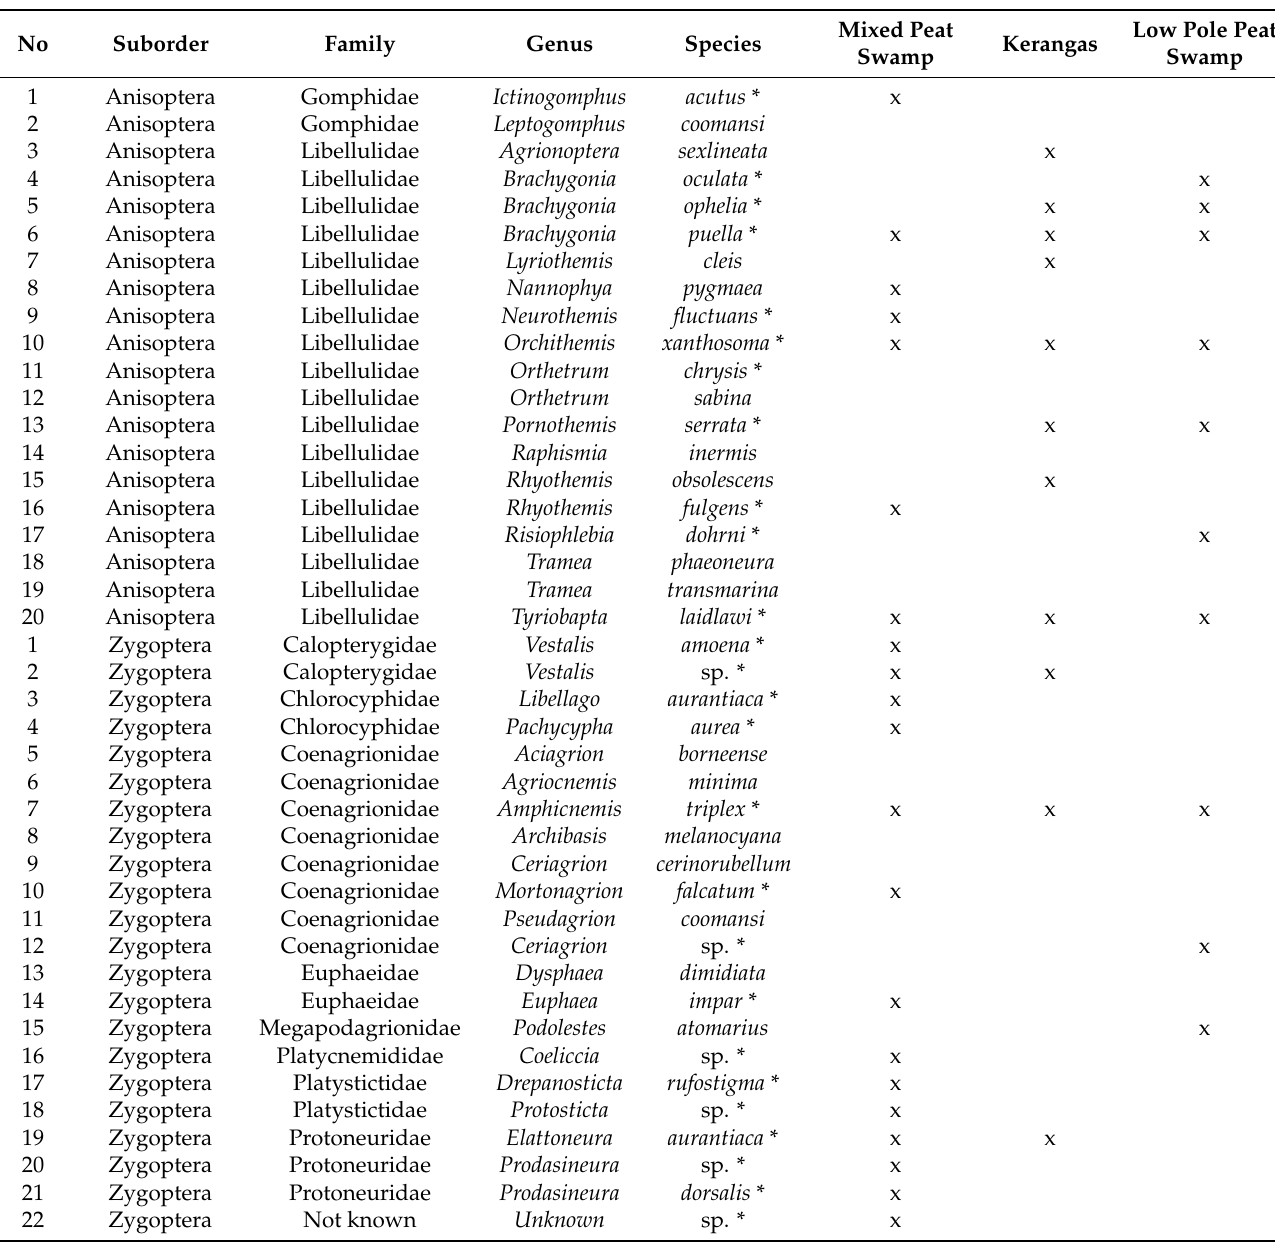
Table A2. A complete species list of all Odonata captured within Kawasan Hutan Dengan Tujuan Khusus. This list includes species captured within surveyed transects (*) and those captured outside of surveyed